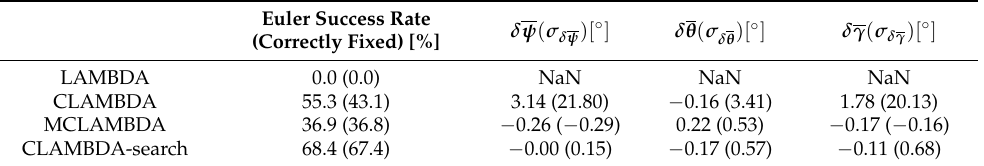
Table 5. GPS/BDS attitude solution of group 1.5 m in degraded environments.